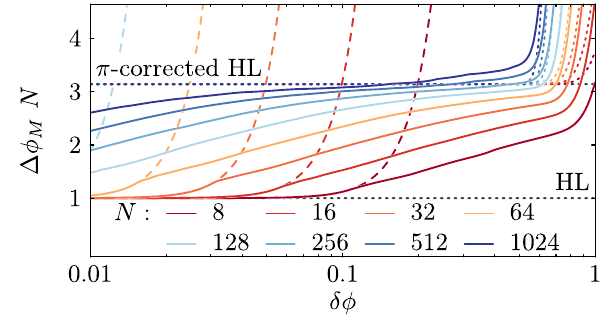
N , i.e., the standard deviation of an FIG. 7. Plot of Δ ϕ M effective measurement rescaled by the ensemble size N , versus prior width δϕ . Solid lines show results for the optimized 2 ; 5 Þ in compari- ; n interferometer with circuit depth ð n en de Þ ¼ ð son to the analytic expression describing a GHZ state interfer- ometer [Eq. (21)] shown with dashed lines and the π -corrected Heisenberg limit including phase slips [Eq. (22)] shown with dotted lines. The Heisenberg limit and the π -corrected Heisenberg limit are indicated with dotted horizontal